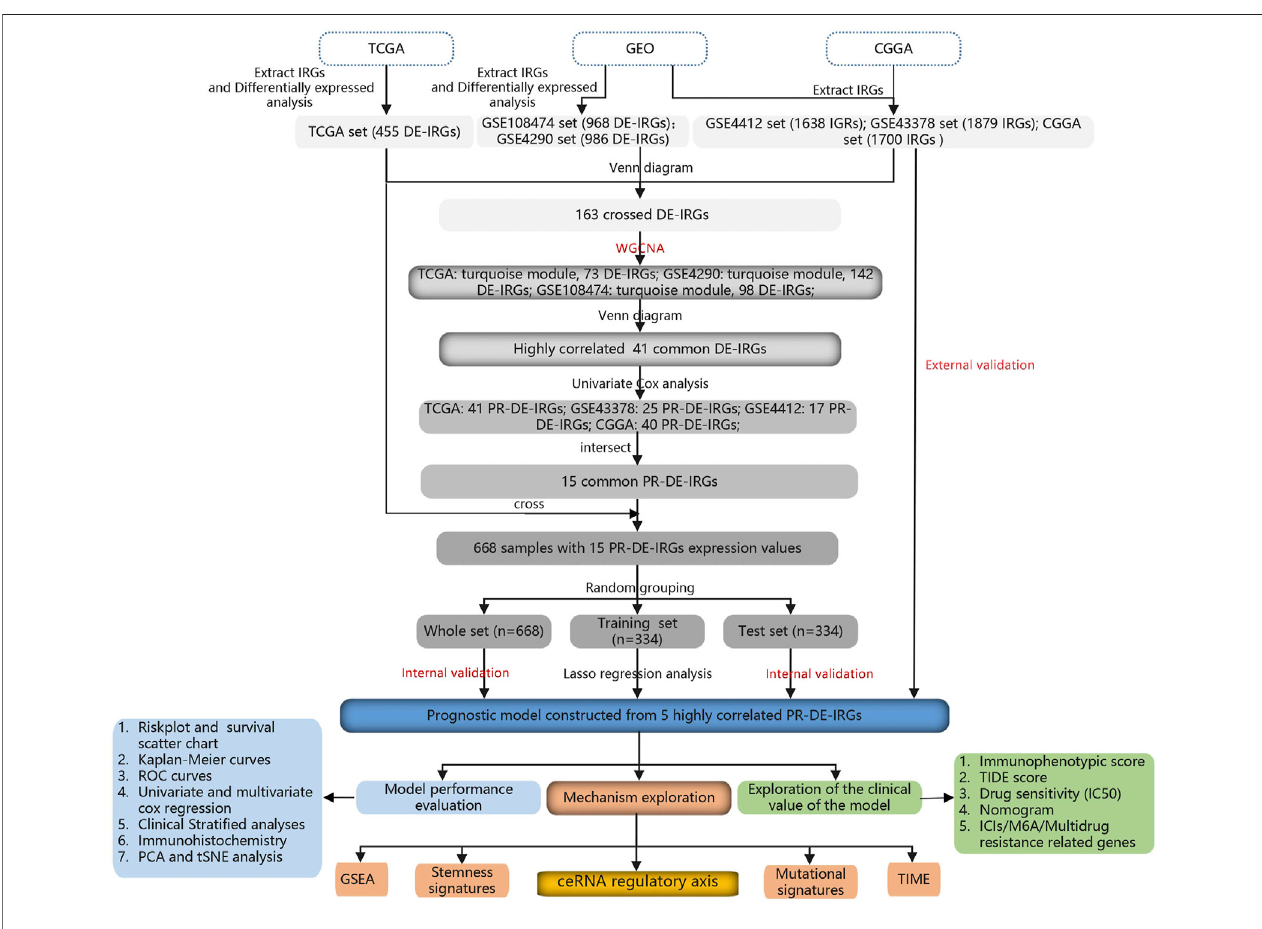
FIGURE 1 | The fl owchart of the whole